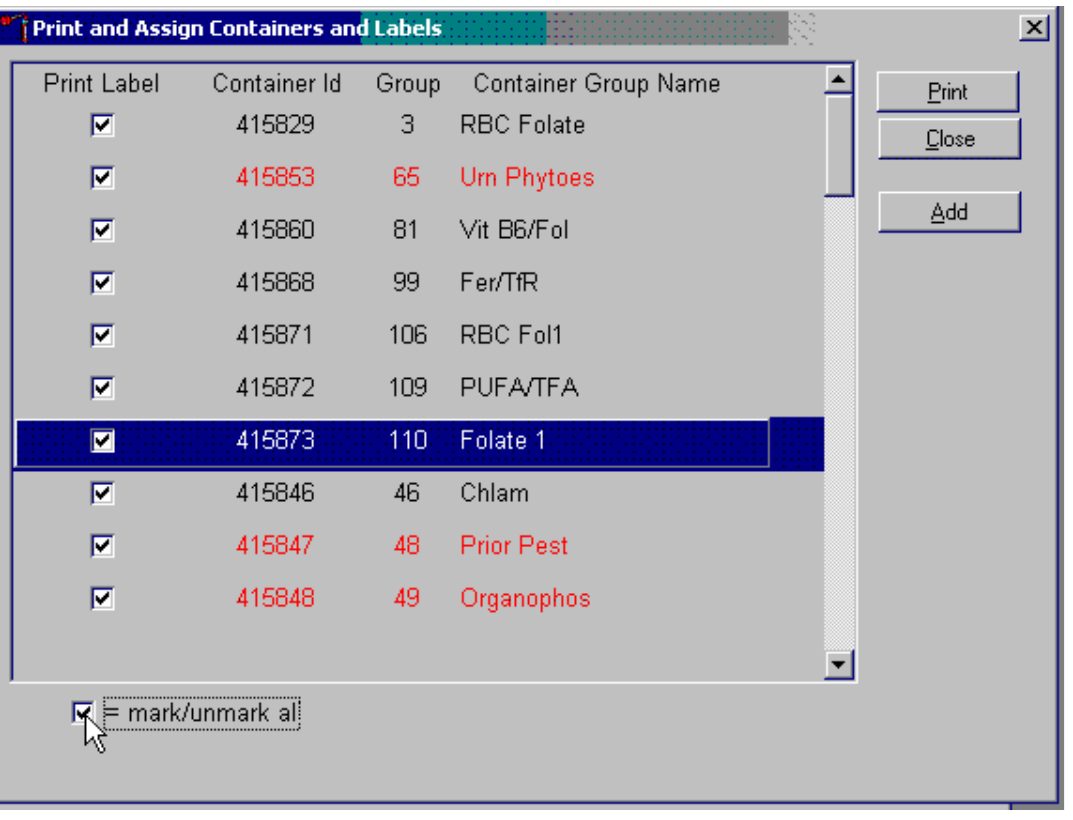
To collectively mark all the check boxes, use the mouse to direct the mouse arrow to the mark/unmark all check box and left click. To collectively unmark all the check boxes, use the mouse to direct the mouse arrow to the mark/unmark all check boxes and left